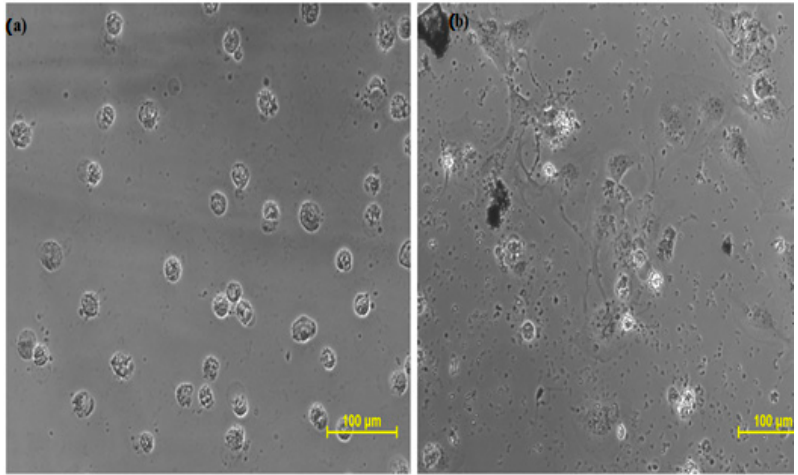
Figure 4. Cytotoxic effect of ( a ) Doxorubicin and ( b ) longifolene on SCC-29B cells.